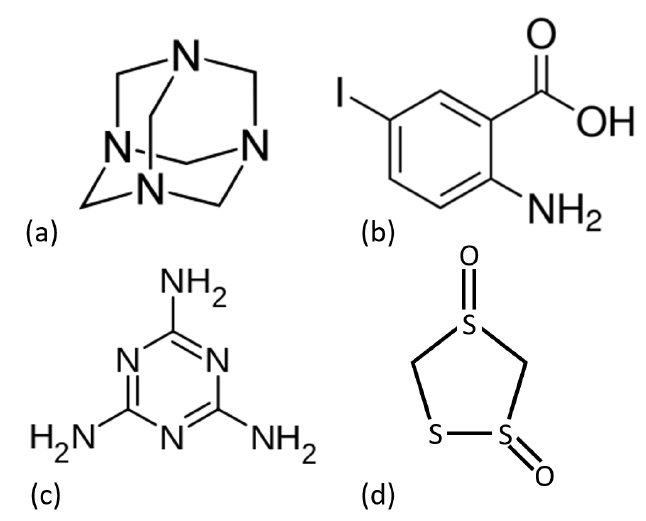
Figure 4. Molecular structures of: ( a ) Hexamine ( b ) IAA ( c ) Melamine ( d )